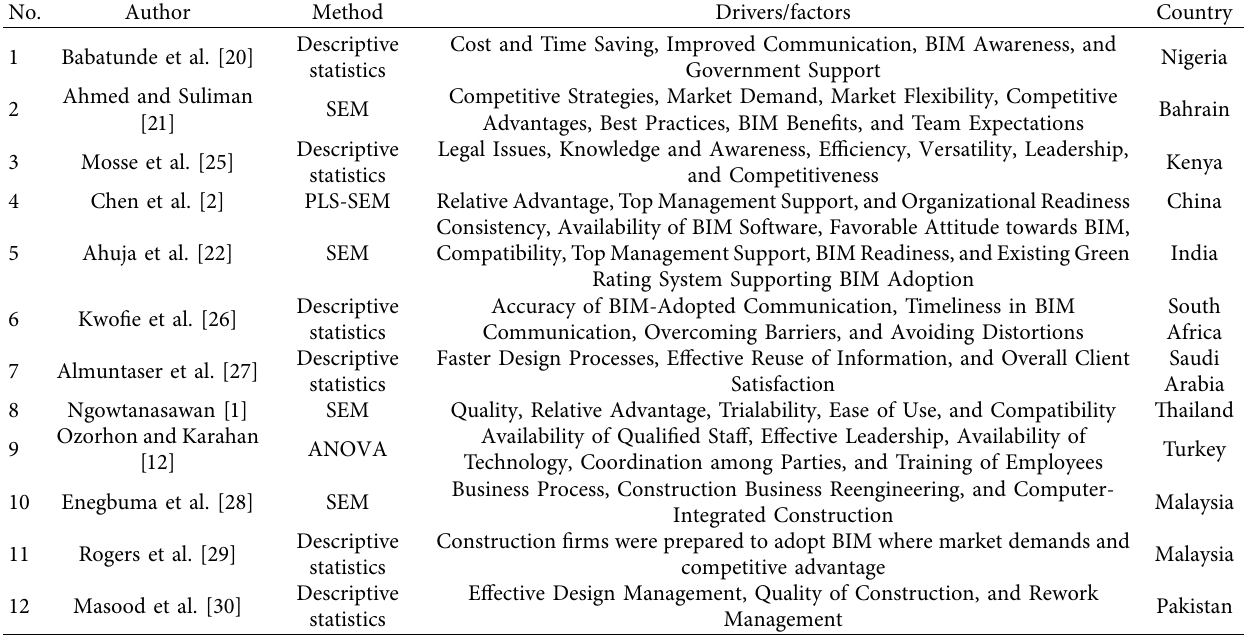
Table 1: Detail summary of shortlisted papers through a systematic literature